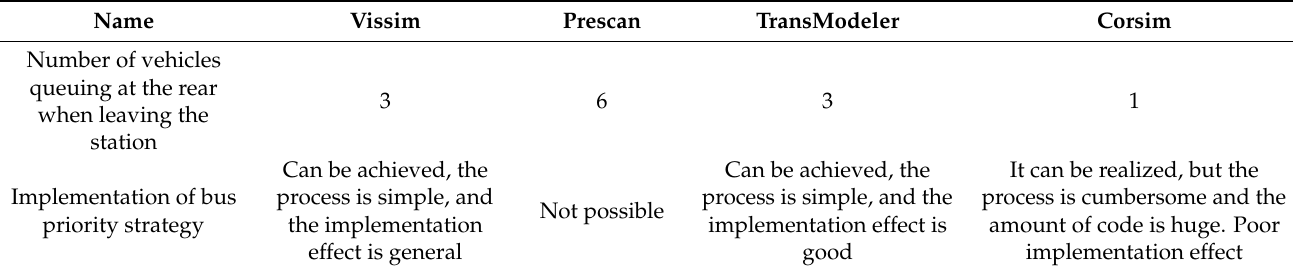
Table 8. Comparison of bus systems with different simulation